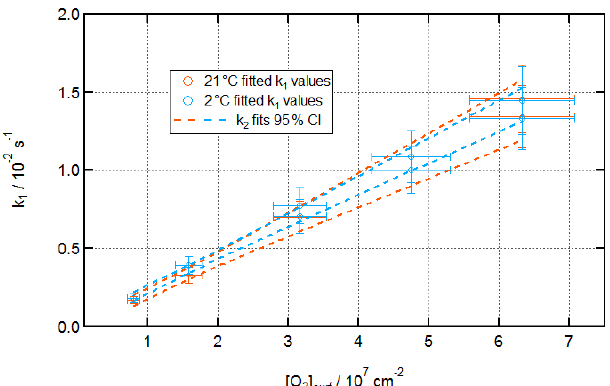
Figure 8. Kinetics of ozonolysis of the oleic acid monolayer on pure water at room and low temperatures. Fitted k 1 pseudo-first-order rate constants against [O 3 ] surf at 21 ± 1 ◦ C (orange) and 2 ± 1 ◦ C